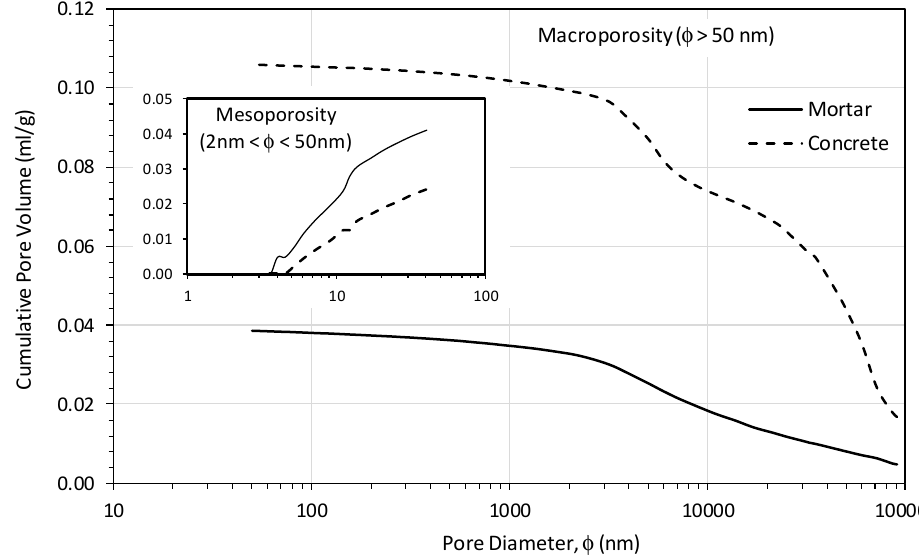
Figure 9. The pore size distribution of geopolymer mortar (50 mm cube) versus concrete (50 mm cube).